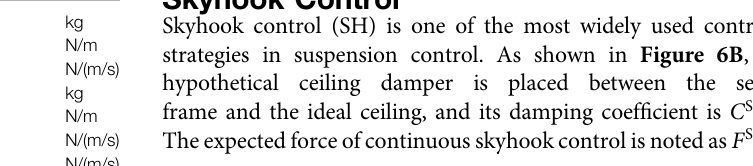
TABLE 2 | Parameter value of the seat suspension system. Parameter Value